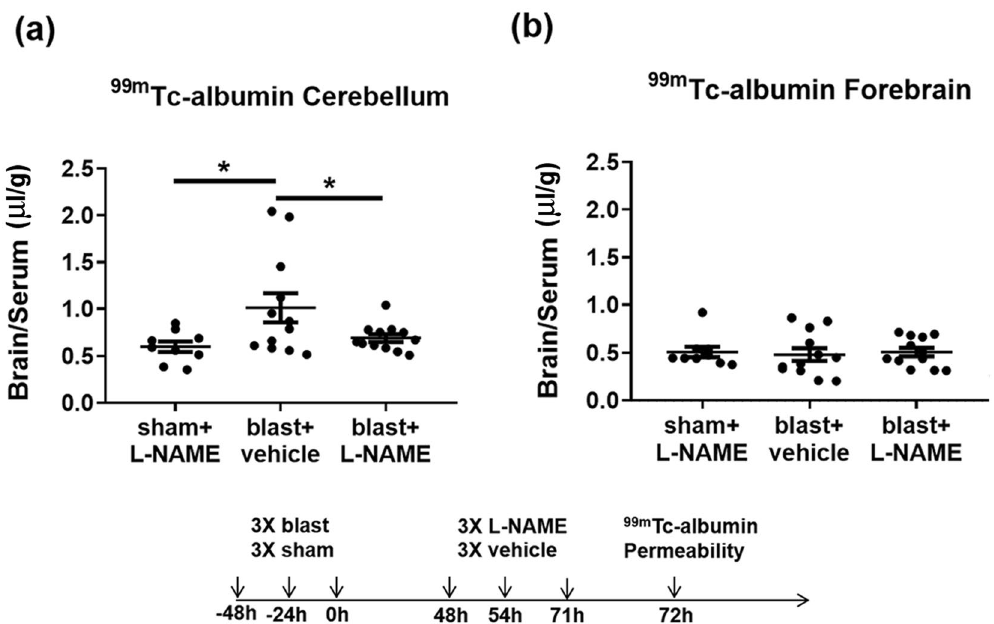
Figure 3. Nitric oxide synthase inhibition blocks blast-induced delayed-onset BBB disruption in cerebellum. (a) 3X blast significantly increased brain/serum ratios of 99m Tc-albumin in the cerebellum ( * p ≤ 0.05), which was significantly attenuated by L-NAME administration (10 mg/kg; ip at 48, 54, and 71 h after the last blast) ( * p ≤ 0.05). (b) No differences were observed in brain/serum ratios of 99m Tc-albumin in the forebrain after repetitive mTBI ( p > 0.05). One-way ANOVA post-hoc Newman-Keuls. Values represent means ± SEM. Timeline portrays the mTBI exposure, L-NAME treatment paradigm, and measurement of BBB